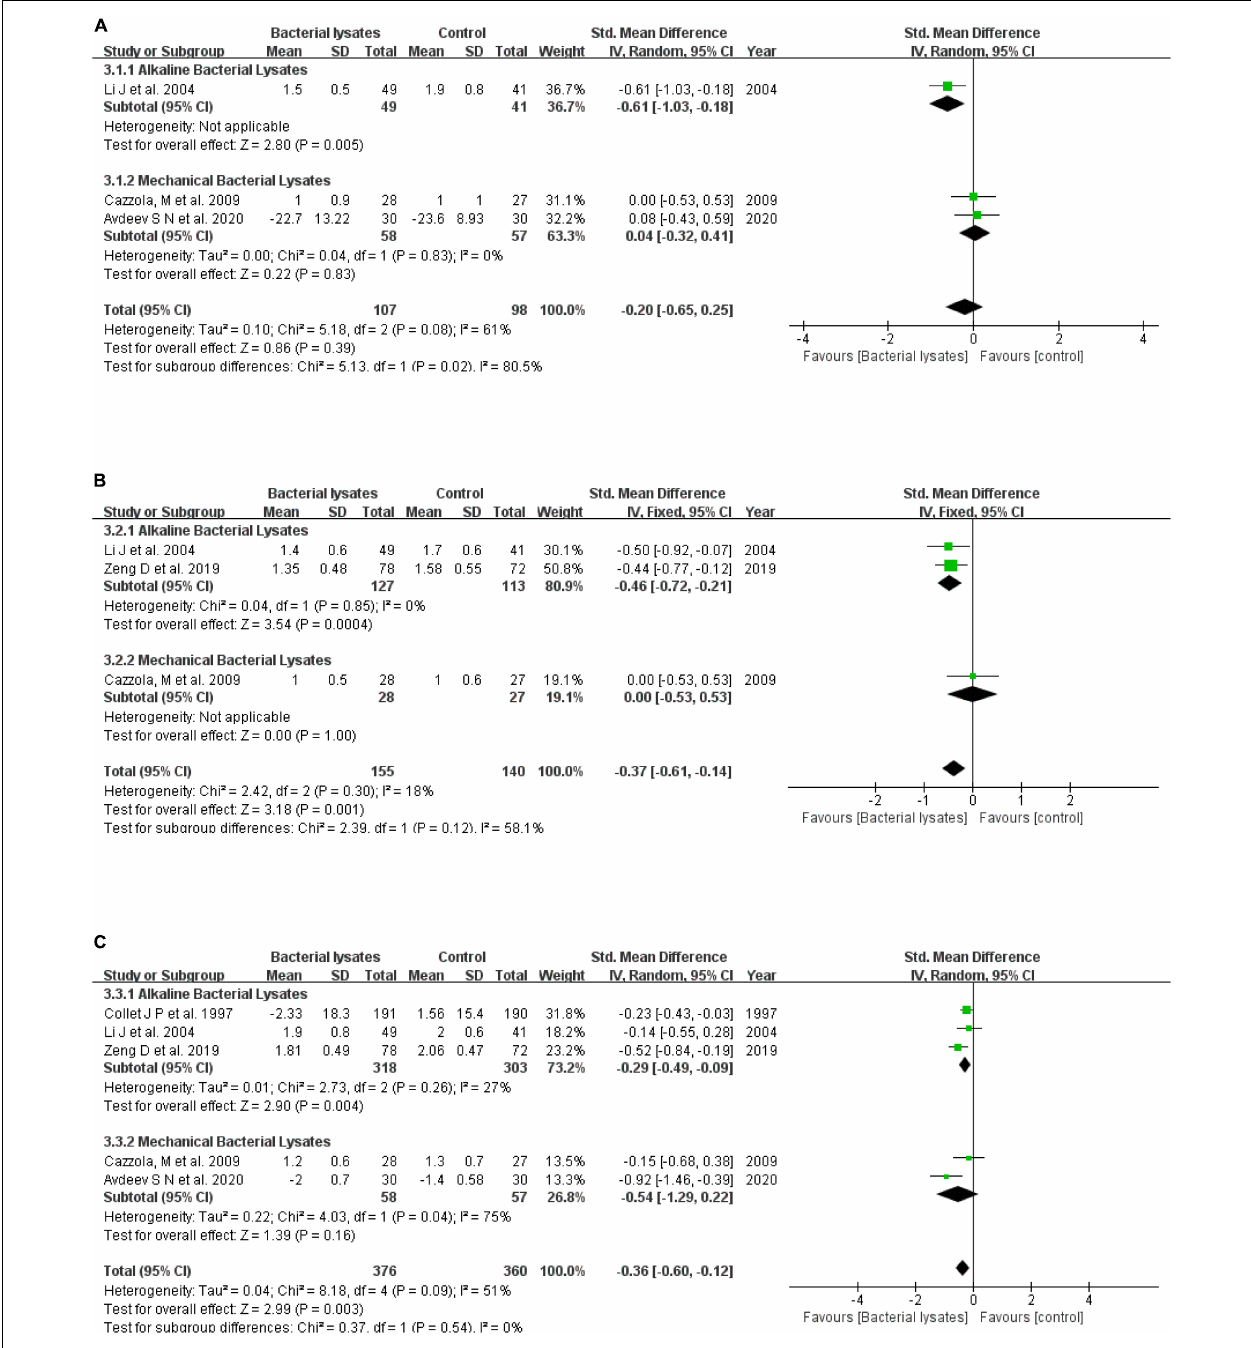
FIGURE 5 | Forest plots of the efficacy of bacterial lysates on symptoms. (A) Sputum, (B) cough, and (C) severity of dyspnea.